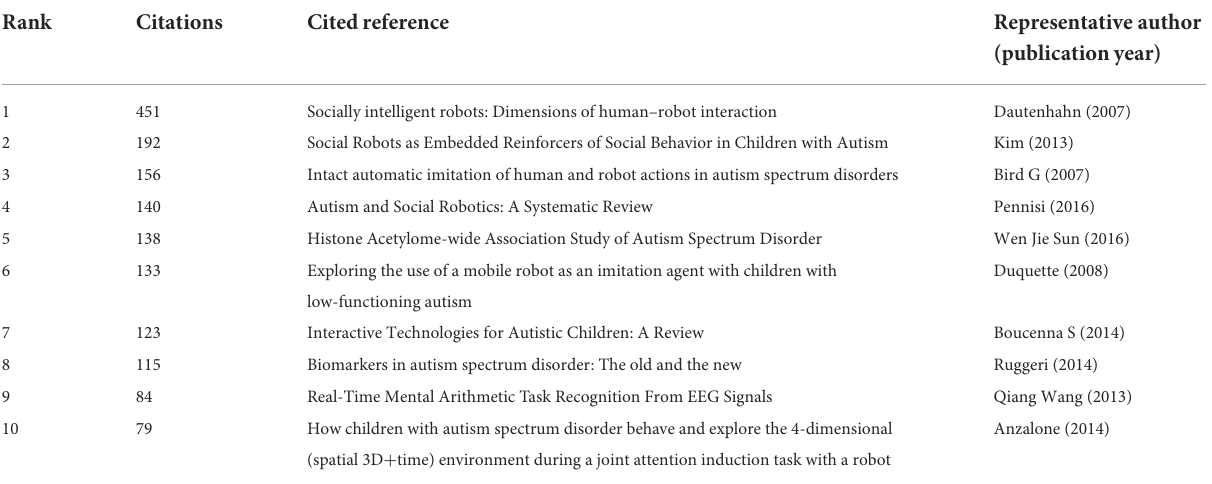
TABLE 8 Top 10 cited references related to AI on ASD in terms of